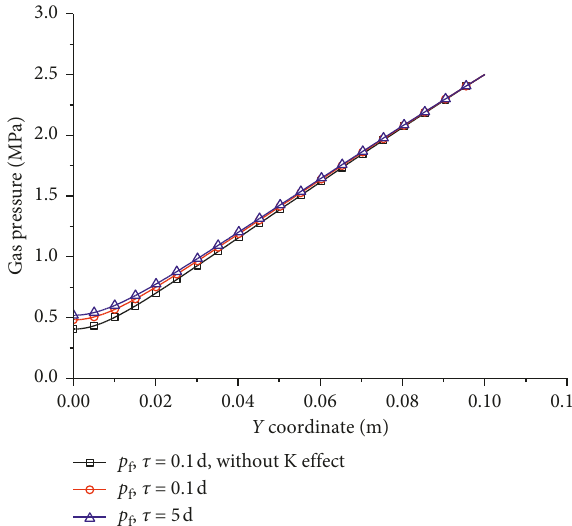
Figure 13: Gas pressure distribution under different